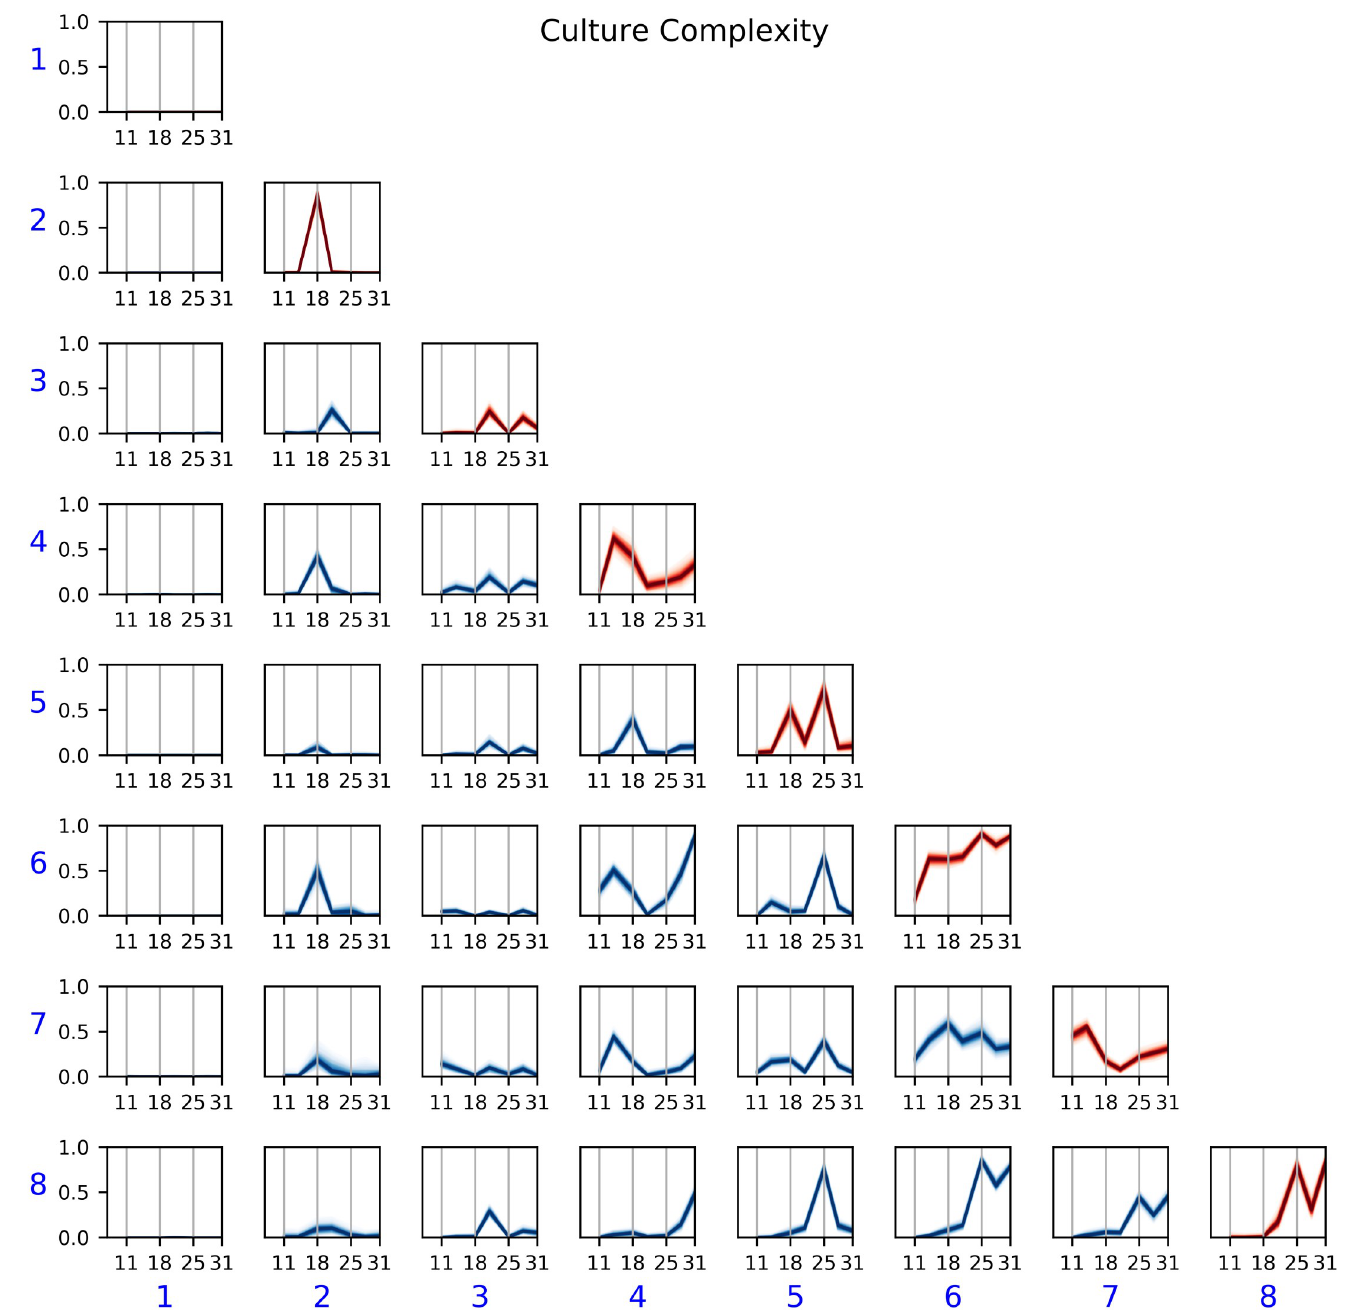
Fig 7. Posterior η as a function of DIV for the Culture Complexity experiment. Blue numbers denote community IDs, and a subplot in row i and column j shows the posterior η i , j —i.e., probability of connection—between a node in community i and a node in community j . Communities associated with complex devices (6–8) showed high probability of connection in later DIV.